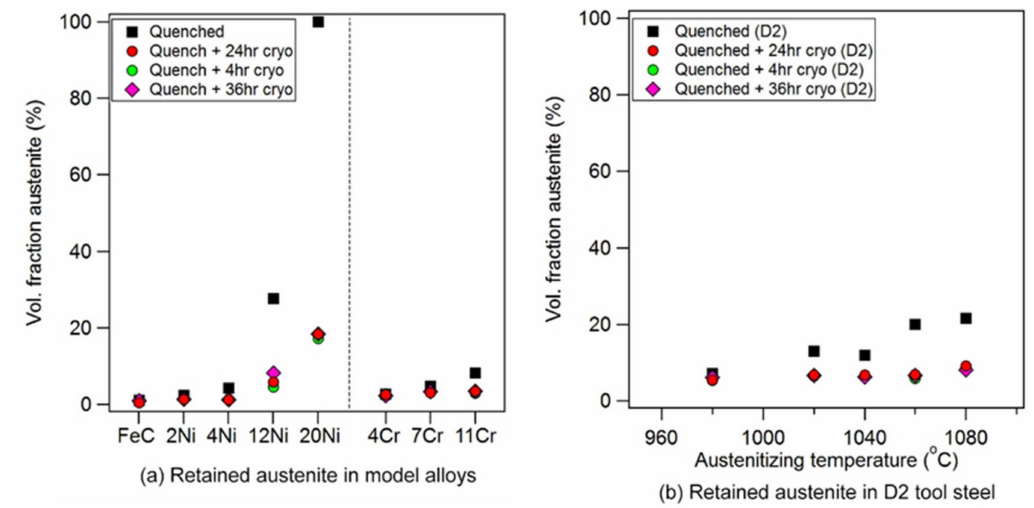
Figure 2. Volume fraction of retained austenite for all alloys examined in this study, which were measured using XRD. Data shown for cryogenic soaking times of 4, 24, and 36 h. The fitting error is approximately the same size as data